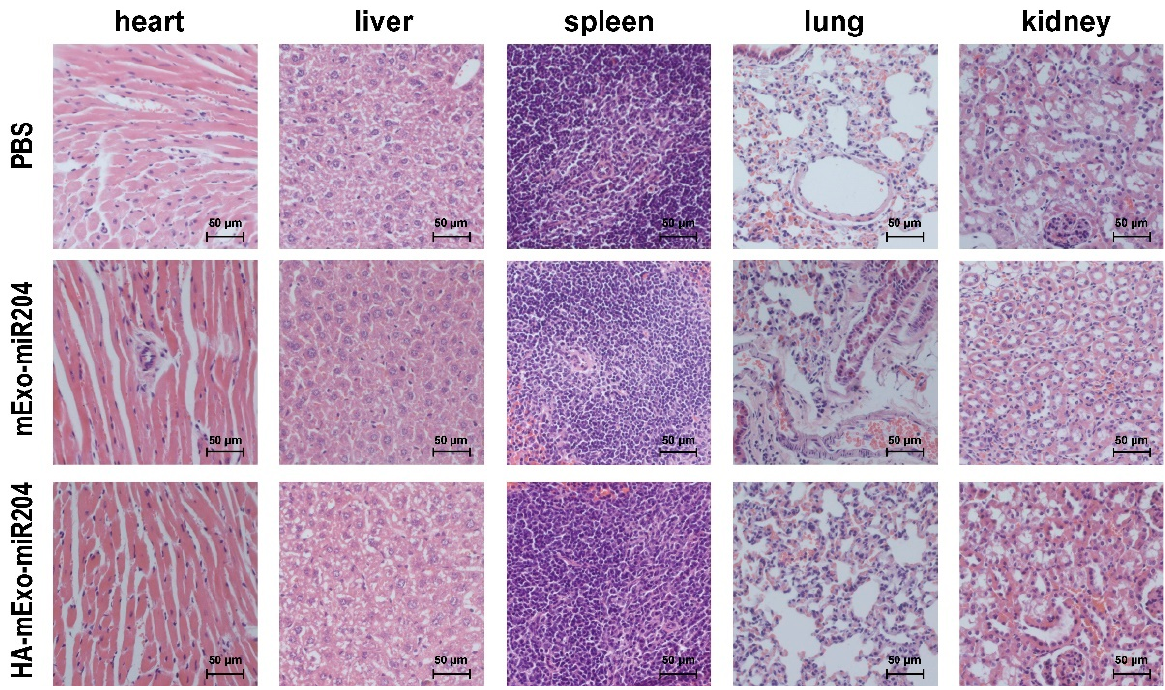
Figure 6. Histological analyses of major organs of mice treated with HA-mExo-miR204. Sections of heart, liver, spleen, lung, and kidney were stained with hematoxylin/eosin. Scale bars: 50 μ m.